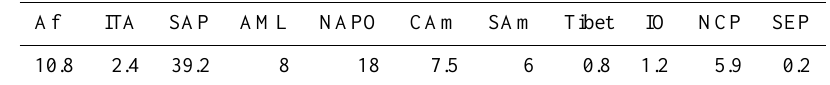
Table 4. Distribution of annual mass flux, averaged over 2005–2008, for all the regions (in%). Af ITA SAP AML NAPO CAm SAm Tibet